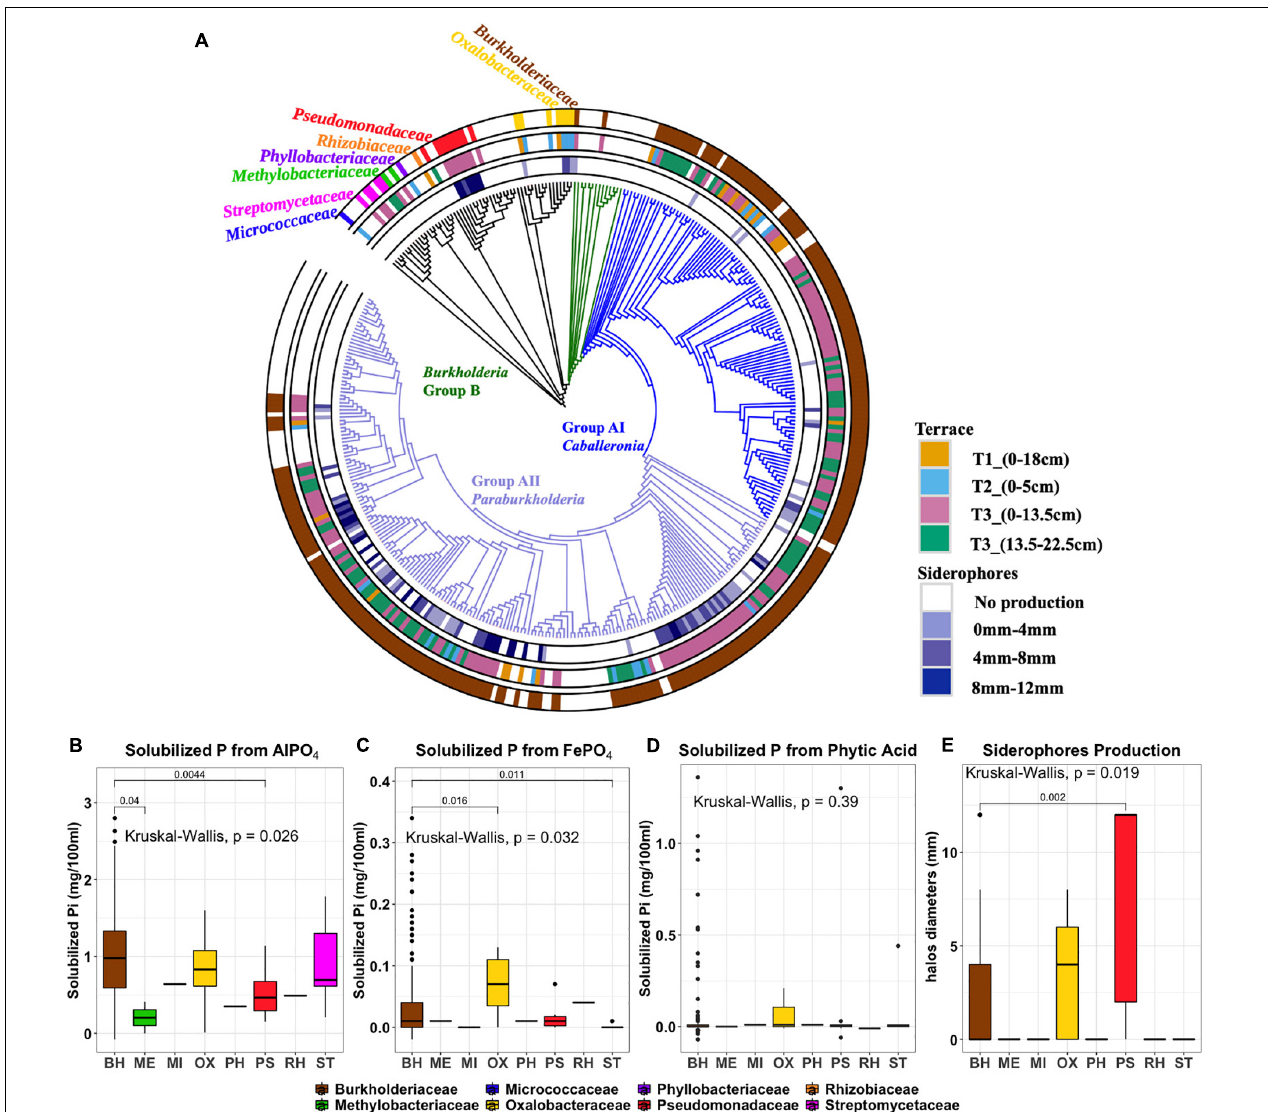
FIGURE 5 | (A) Phylogenetic tree of 270 ES isolates and representative sequences as references. Rings, from the outer to the inner circles, represent: Ring1, taxonomy at family level. Ring2, Terrace of origin. Ring3: Siderophore production, with color gradient representing the diameter of colored halo production. (B) aluminum phosphate solubilization (C) iron phosphate solubilization (D) phytic acid solubilization (E) siderophore production. Outliers are denoted as large points outside whiskers. The Kruskal-Wallis test was used to compare the differences of P solubilization between isolates from different bacterial families. The Mann-Whitney-Wilcoxon was used to conduct pairwise post hoc